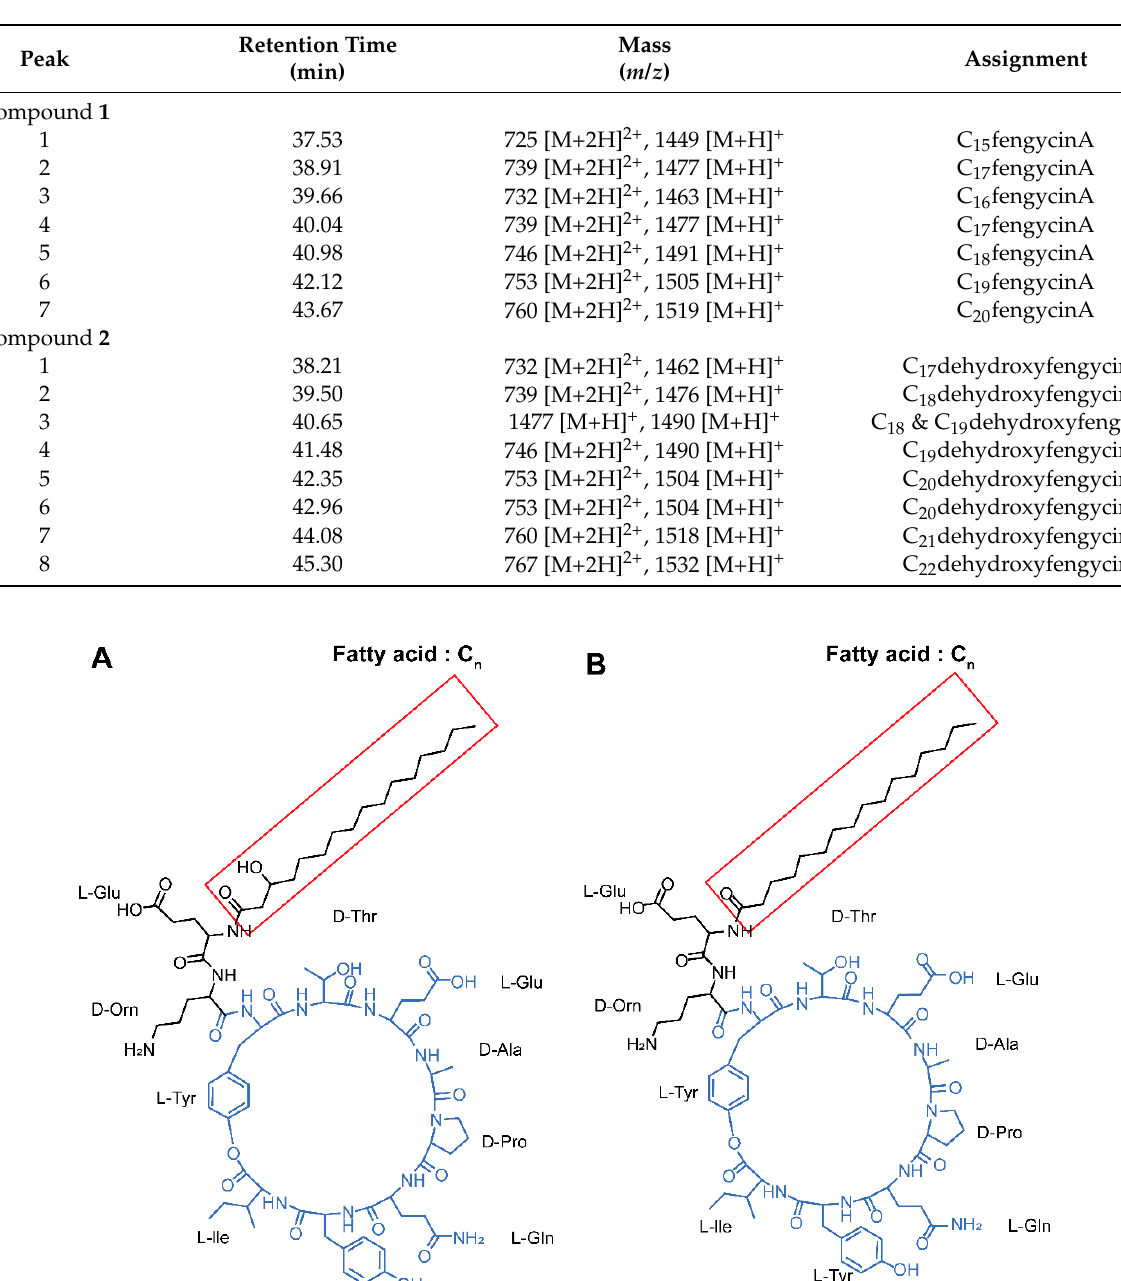
Table 1. Main mass peaks of compounds 1 and 2 from Bacillus subtilis SA-15 characterized by LC-ESI-MS.